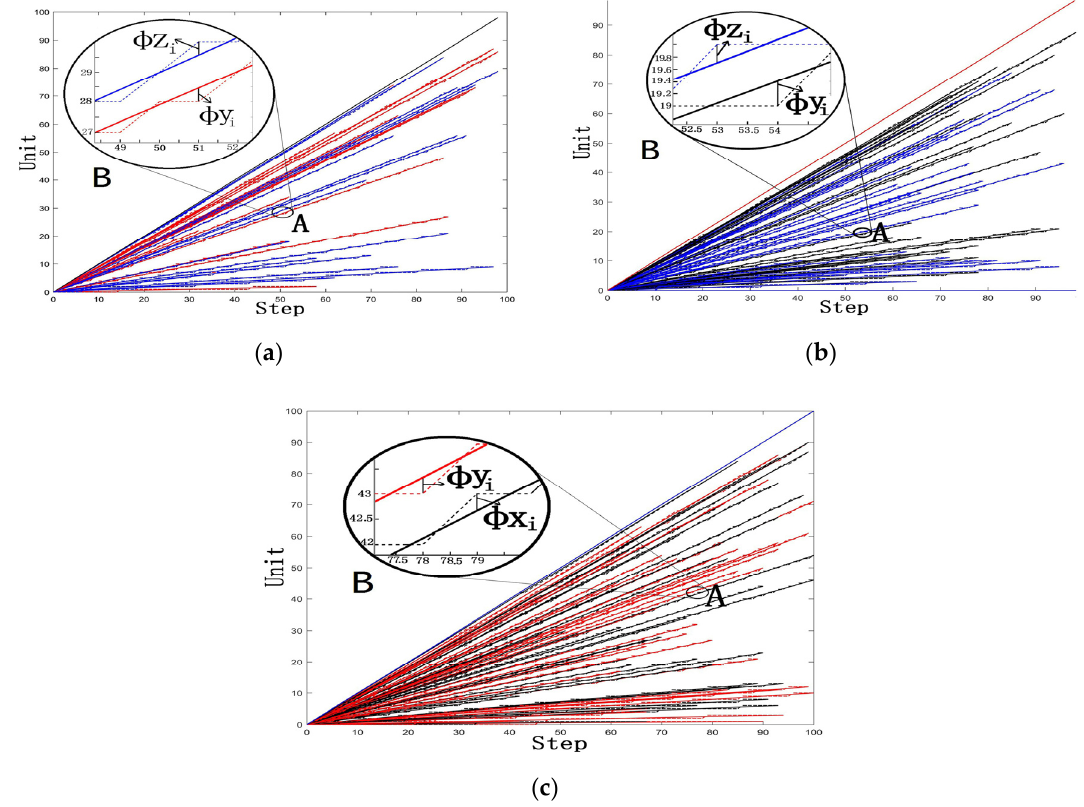
Figure 7 . The 100 groups of straight-line results . ( a )The x -axis with the largest change. ( b ) The y -axis Figure 7. The 100 groups of straight-line results. ( a ) The x-axis with the largest change. ( b ) The y -axis with the largest change. ( c ) The z -axis with the largest change. with the largest change. ( c ) The z -axis with the largest